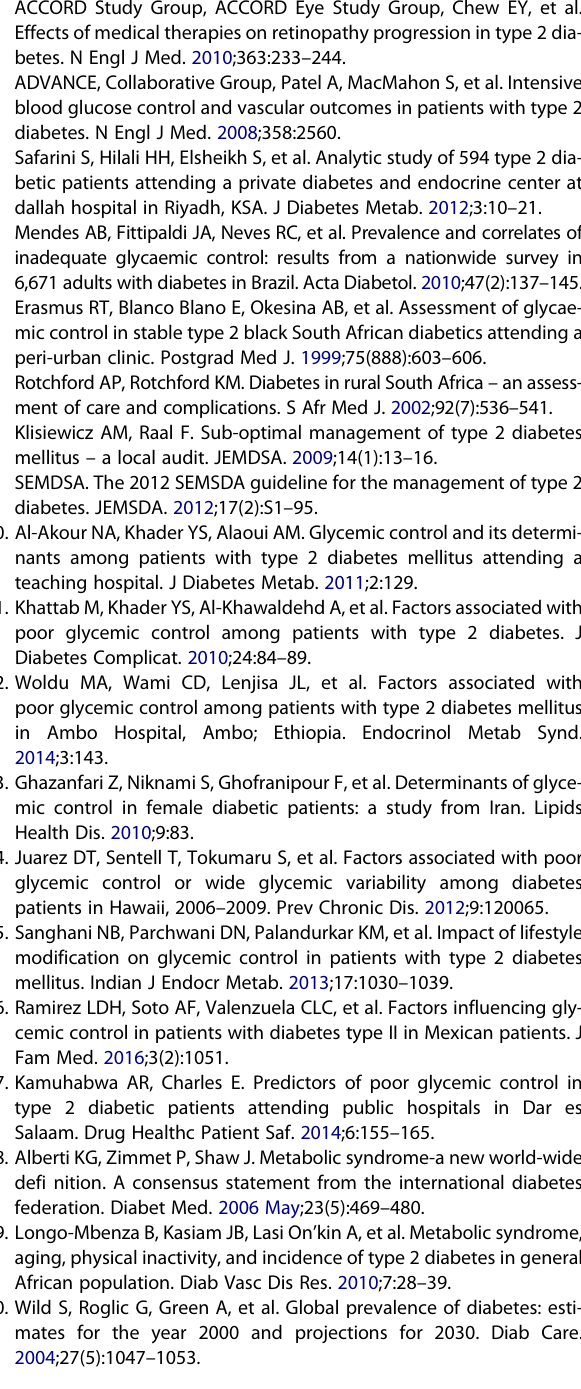
Factor B S.E. Wald df Sig.